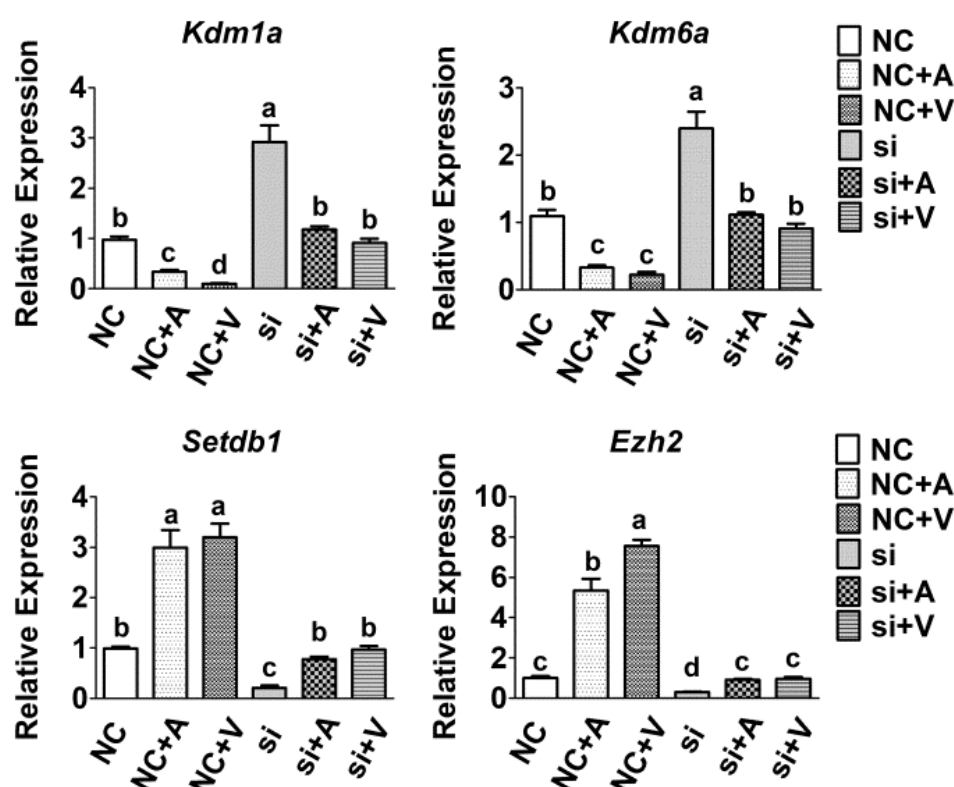
Figure 6. Tet2 regulated the mRNA expression of histone de/methyltransferases in myoblasts. The expression of histone methyltransferases and demethyltransferases in myoblasts treated by 5-AZA and VC after Tet2 knockdown was measured by qRT-PCR. Data are presented as the means ± SEM. Different letters indicate significant difference ( p < 0.05).